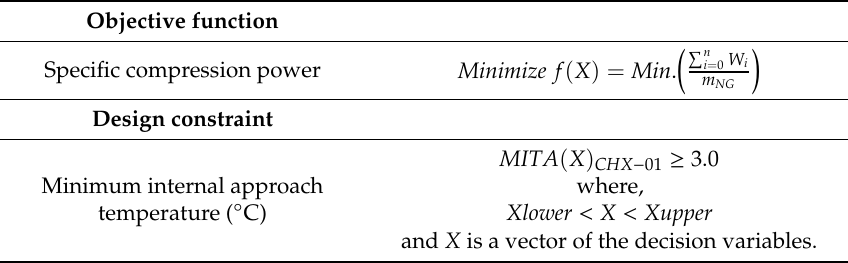
Table 5. Objective function, constraint, and design variables for N 2 dual expander and SMR processes.